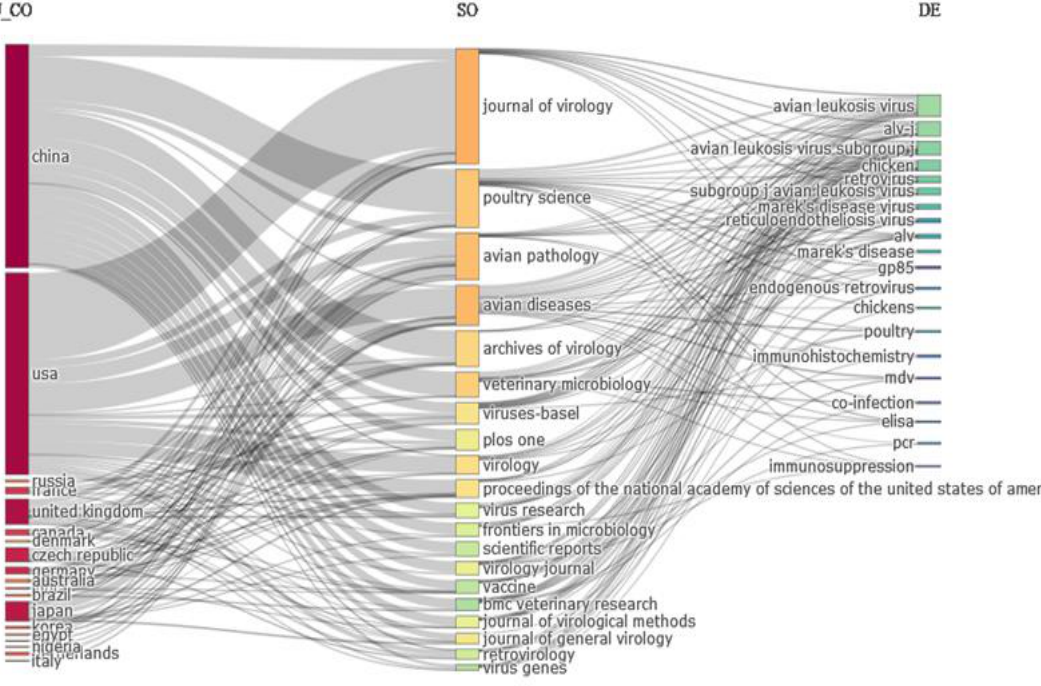
Figure 5. Sankey diagram of three-factor analysis, indicating the association and connectivity